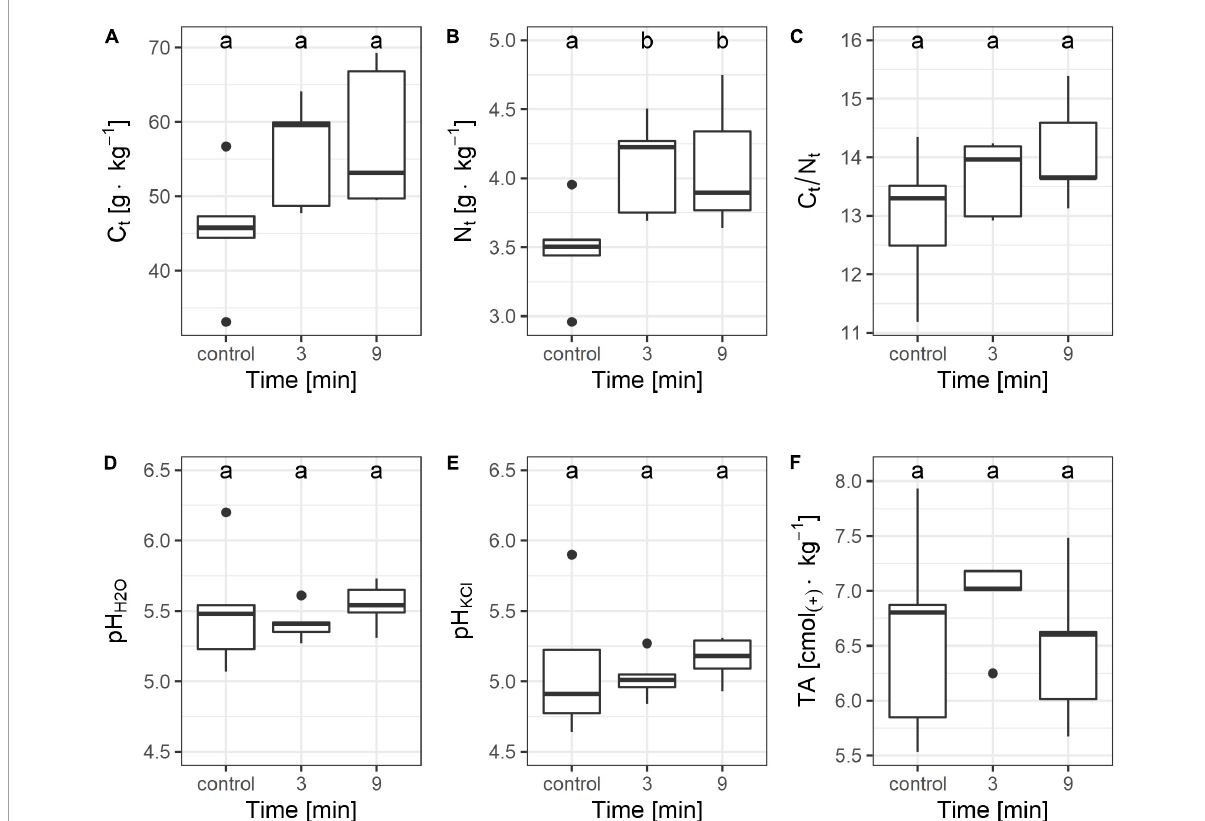
FIGURE2 Total C (A) , total N (B) , C t /N t ratio (C) , pH in H 2 O (D) and in KCl (E) , total acidity (F) plotted against the time of soil burning. Different letters on this figures indicate significant differences between the groups (according to Duncan test, p < 0.05). The line within the box represents median; the box represents interquartile range; the whiskers represent the largest and the smallest value within 1.5 times interquartile range above 75th and below 25th percentile, respectively; the points represent